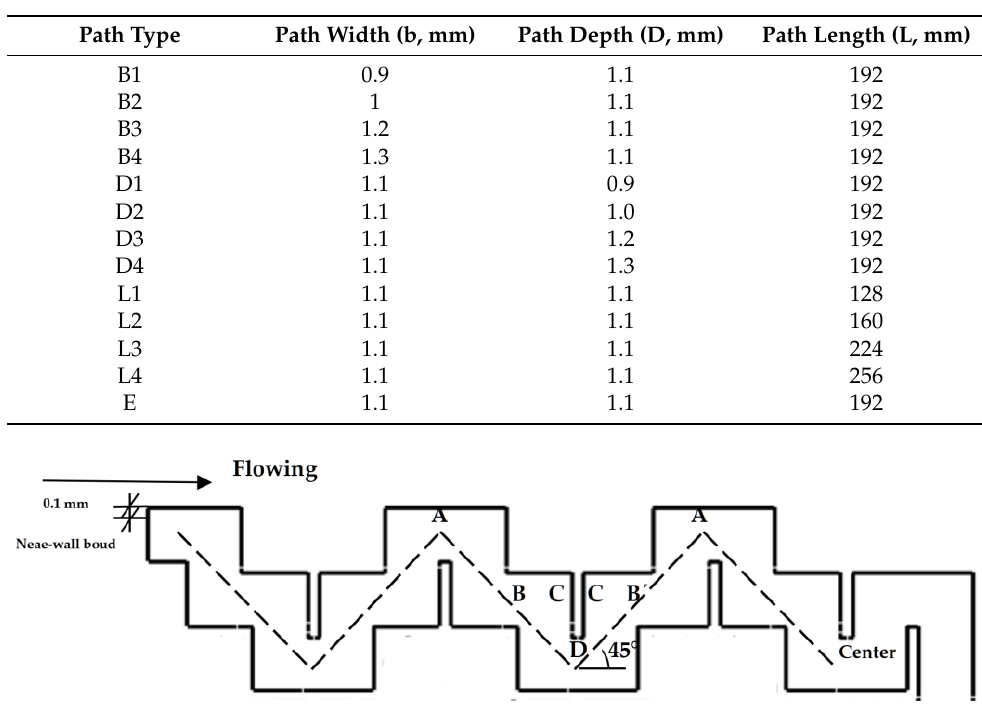
Table 1. Experimental design parameters for different structural geometry parameters of the Minkowski fractal flow path.